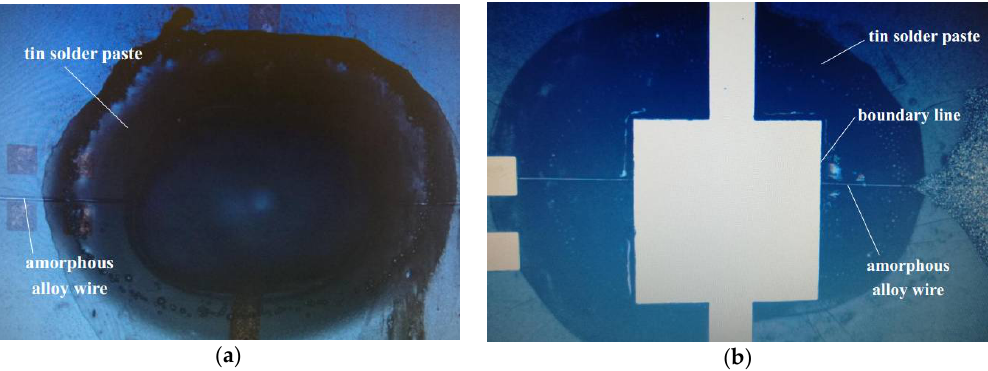
Figure 6. ( a ) The front image; and ( b ) the back image of the solder paste and the amorphous wire contact points under the microscope. The filled area of the tin solder paste is a square.